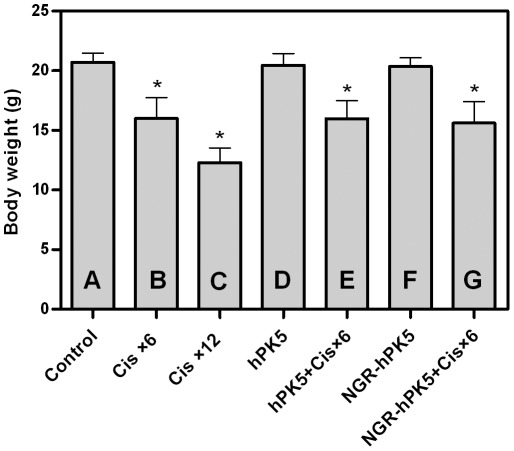
The effect on body weight analysis of hPK5/NGR-hPK5 and cisplatin.C57BL/6J mice were injected i.p. with either PBS or cisplatin, recombinant protein alone or combined with cisplatin. On day 1 after post-treatment, the body weight was observed. A
, Control (PBS); B
, Cisplatin at 2 mg/kg/day dose every other day (6 times totally); C
, Cisplatin at 2 mg/kg/day dose every day (12 times totally); D
, hPK5 at 1.25 mg/kg/day dose every other day (6 times totally); E
, hPK5+cisplatin (B); F
, NGR-hPK5 at 1.25 mg/kg/day dose every other day (6 times totally); G
, NGR-hPK5+cisplatin (B). Five mice were used in each sample group, and the data shown were the mean volume ± SD. * p<0.05 compared with control.